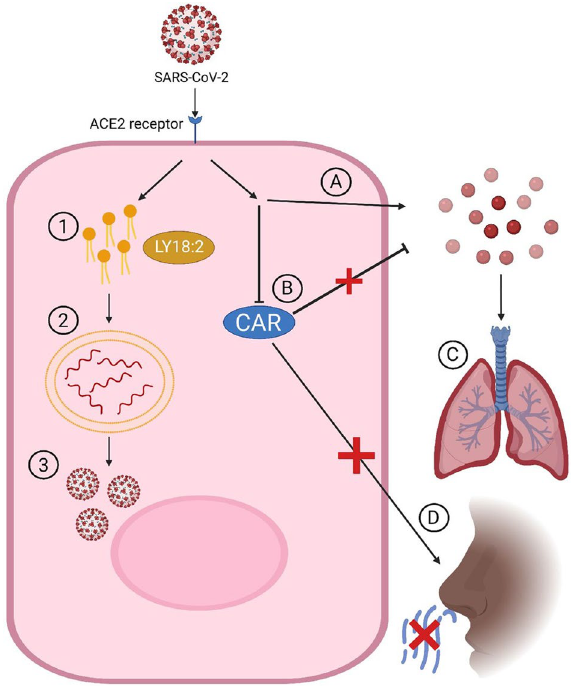
Figure 5. Schematic view of SARS-CoV-2 infection and potential mechanisms of symptom generation involving significantly altered metabolites. ( 1 ) After viral entry into the cell an increase in lipid generation occurs through viral hijacking of cell machinery. ( 2 ) Lipids are used to generate double membrane vesicles for replication. ( 3 ) Release of new Coronavirus. ( A ) SARS-CoV-2 leads to an elevation in oxidative stress by generation of reactive oxygen species (ROS). ( B ) Decreased levels of Carnosine results in a reduced ability for antioxidant clearance of ROS. ( C ) Oxidative stress and inflammation can damage the lungs and lead to further symptoms of COVID-19. ( D ) Reduction of Carnosine within the cells of the olfactory may be implicated in anosmia, a common symptom of